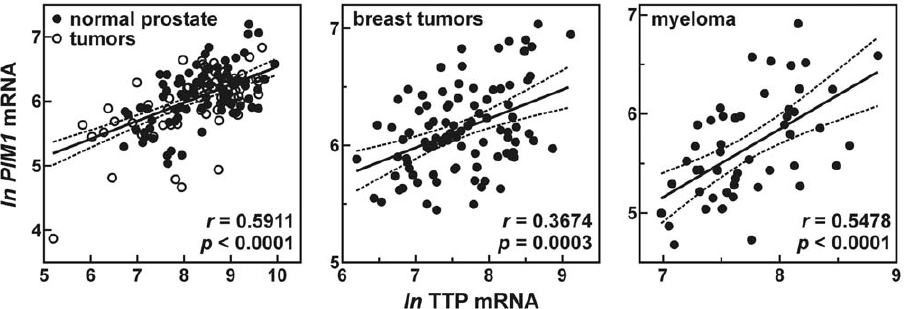
Figure 6. Coordinated expression of PIM1 and TTP mRNAs in selected human tissues. Levels of PIM1 and TTP mRNAs were extracted from gene array datasets derived from a panel of human non-transformed (normal) and tumorous prostate tissues (Gene Expression Omnibus accession no. GSE6919), breast tumors (Gene Expression Omnibus accession no. GSE2294), and CD138 + cells purified from bone marrow of multiple myeloma (MM) patients (Gene Expression Omnibus accession no. GSE2912). Correlation between levels of PIM1 and TTP mRNAs was analyzed using the Spearman nonparametric test. Correlation coefficients ( r ) and associated p values are listed in each panel. The dotted lines indicate the 95% confidence intervals of each regression solution.